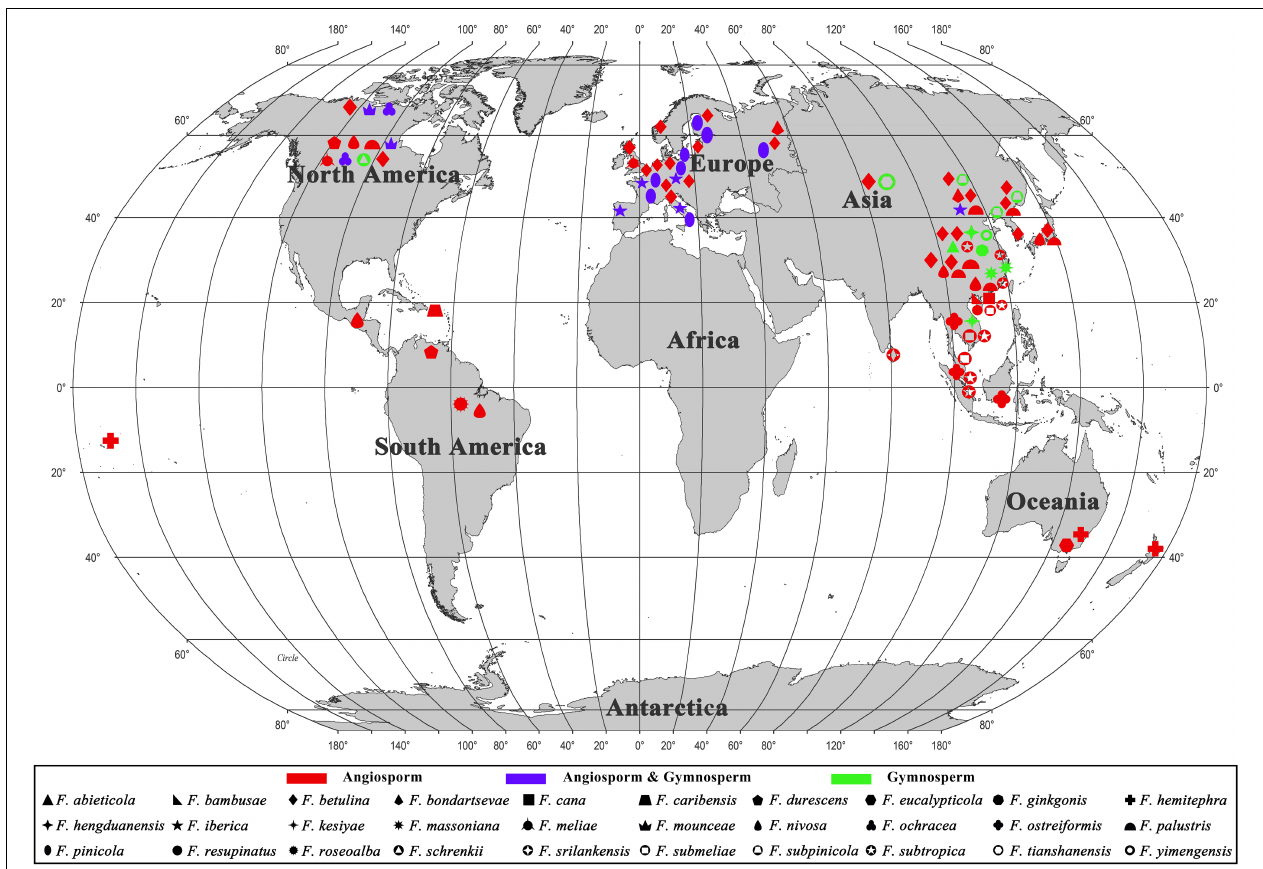
FIGURE 7 | The geographical locations of the Fomitopsis species distributed in the